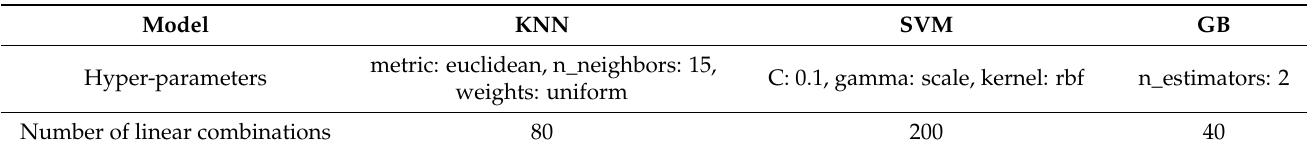
Table 3. The hyper-parameters obtained using a specific number of videos for the (a) KNN (b) SVM and (c) GB models.